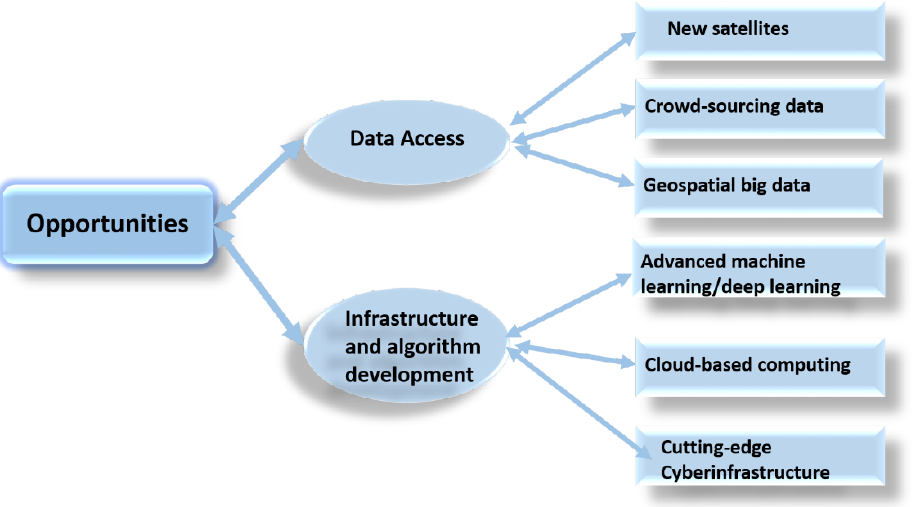
Figure 1. Major opportunities of LULC mapping in the era of big data.